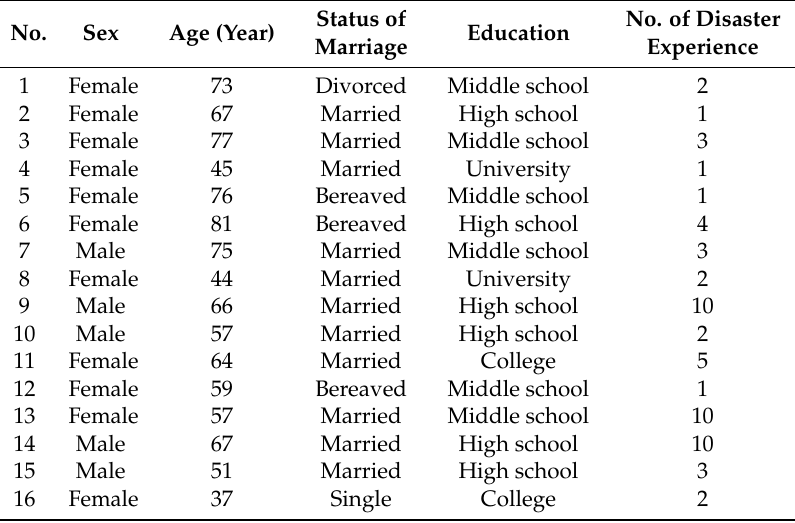
Table 1. General characteristics of the participants.